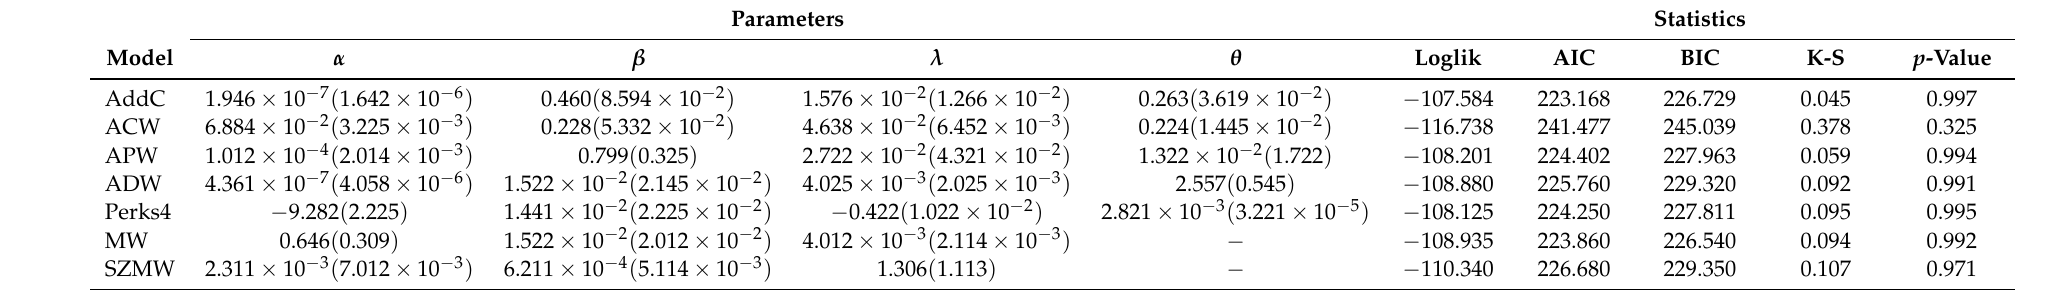
Table 7. Estimated Values, standard errors in brackets and Statistics metrics for the Case of Study